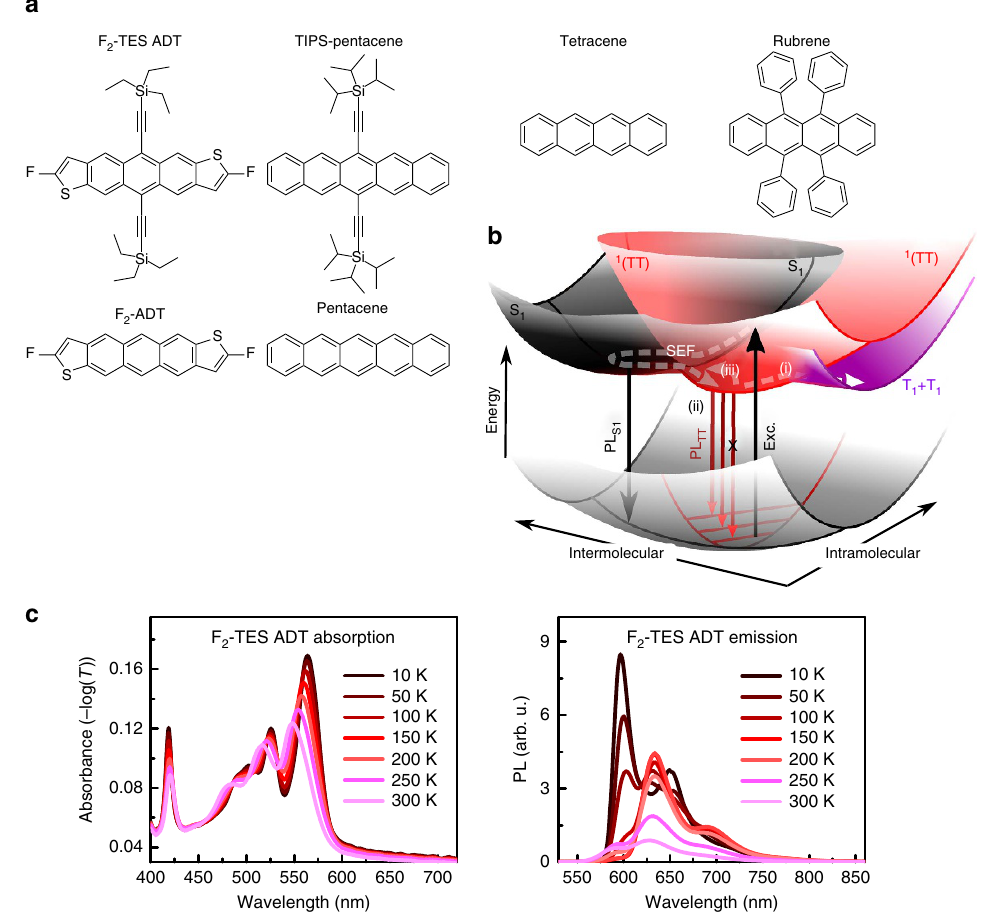
Figure 1 | Singlet exciton fission in polyacenes. ( a ) Molecules investigated in this study. ( b ) Schematic potential energy surface denoting key photophysical processes (dashed arrows) in singlet fission materials. Photoexcitation (Exc.) is followed by singlet (black) relaxation along inter- and intramolecular coordinates, resulting in the observed Stokes shift (PL S1 ). Further relaxation into the bound, spin-coherent triplet pair state 1 (TT) (red) constitutes singlet exciton fission (SEF). Three detectable decay processes are possible from 1 (TT). (i) Thermally activated dissociation into free triplets (purple), which is aided by disorder/grain boundaries and exhibits a typical activation energy of 20–40meV. (ii) Direct ‘delayed’ emission from 1 (TT) (PL TT ) through Herzberg–Teller intensity borrowing. As a consequence of this mechanism, the 0-0 transition is suppressed. (iii) Thermally activated back-transfer into the singlet manifold. This process results in delayed fluorescence (PL S1 ), and is suppressed in tetracene and F 2 -TES ADT at r 200K, indicating the presence of a slight energy barrier. ( c ) Temperature-dependent absorption and PL spectra of F 2 -TES ADT